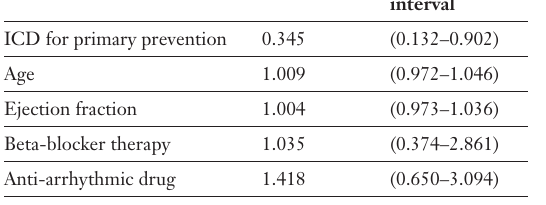
Kaplan-Meier estimate curves of freedom from appro- priate defibrillator interventions in the primary prevention and the secondary prevention